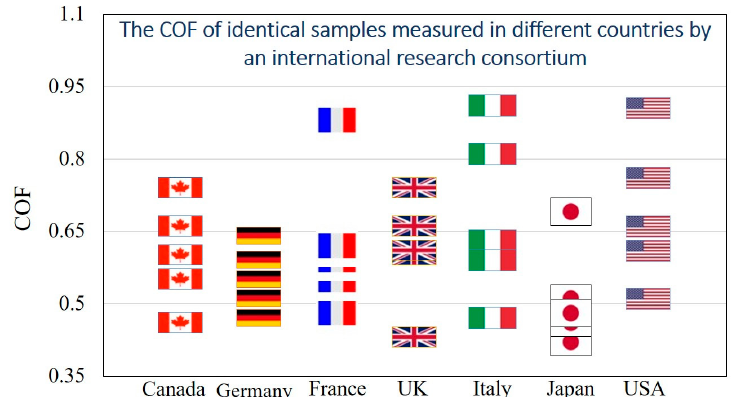
Figure 3. Coe ffi cient of friction (COF) vs. country: Data on the COF of identical steel / aluminum-oxide Figure 3. Coefficient of friction (COF) vs. country: Data on the COF of identical steel/aluminum-oxide sample pairs measured in di ff erent laboratories in di ff erent countries of the world. Each flag represents sample pairs measured in different laboratories in different countries of the world. Each flag an experimental point from a represents an experimental point from a laboratory.